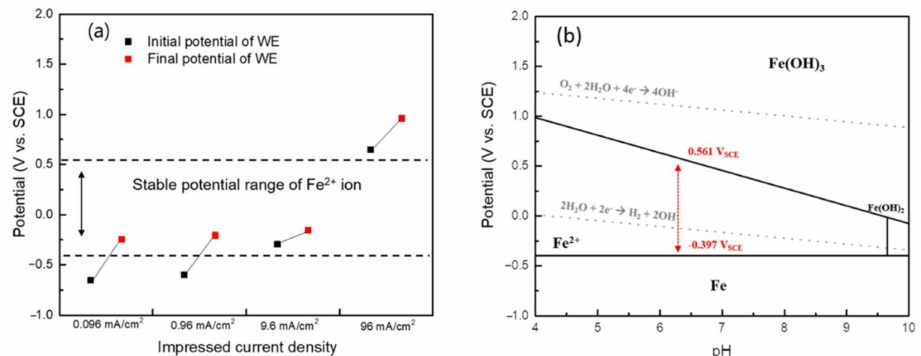
Figure 3. ( a ) Initial and final potentials during the GS test, and ( b ) Pourbaix diagram of an Fe-H 2 O system (activity of Fe 2+ : 10 − 6 , 60 ◦